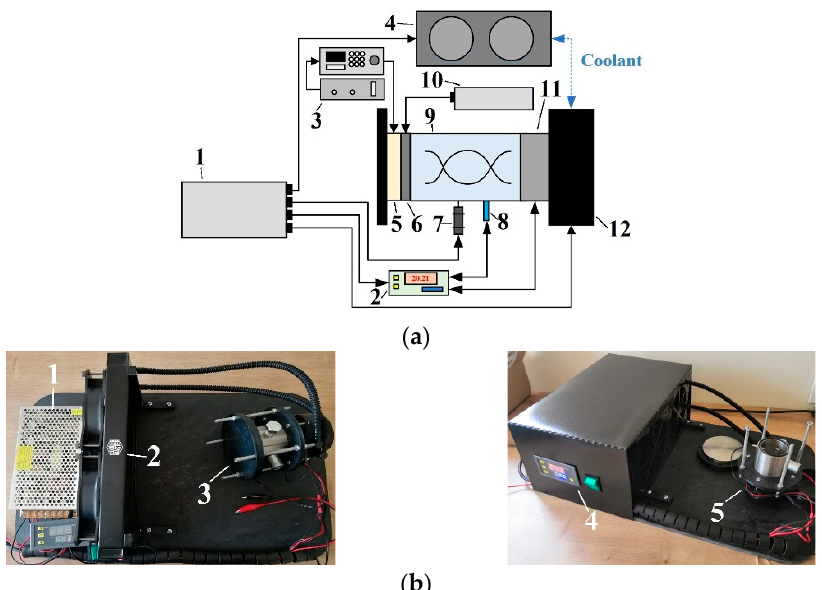
Figure 2. Experimental setup for manufacturing the AAO nanoporous membrane. ( a ) A schematic representation of the experimental setup: 1: DC 1 power unit, 2: temperature control device, 3: voltage amplifier and frequency generator, 4: master cooler radiator, 5: piezoelectric actuator, 6: membrane, 7: mixing device, 8: temperature sensor, 9: electrochemical reactor, 10: DC 2 power unit, 11: Peltier element, 12: master cooler pump; ( b ) Experimental equipment: 1: DC 1 power unit, 2: master cooler, 3: closed electrochemical reactor, 4: temperature control device, 5: open electrochemical reactor.